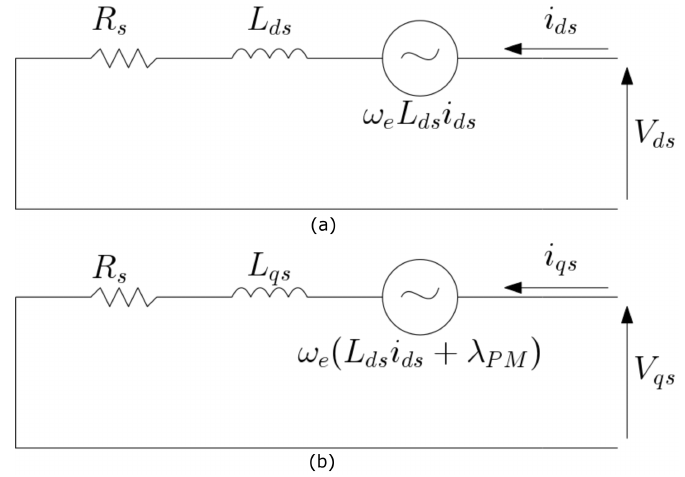
Figure 3. Permanent magnet synchronous generator (PMSG) dq equivalent circuit, based on [27], where ( a ) represents the d-axis and ( b ) represents the q-axis